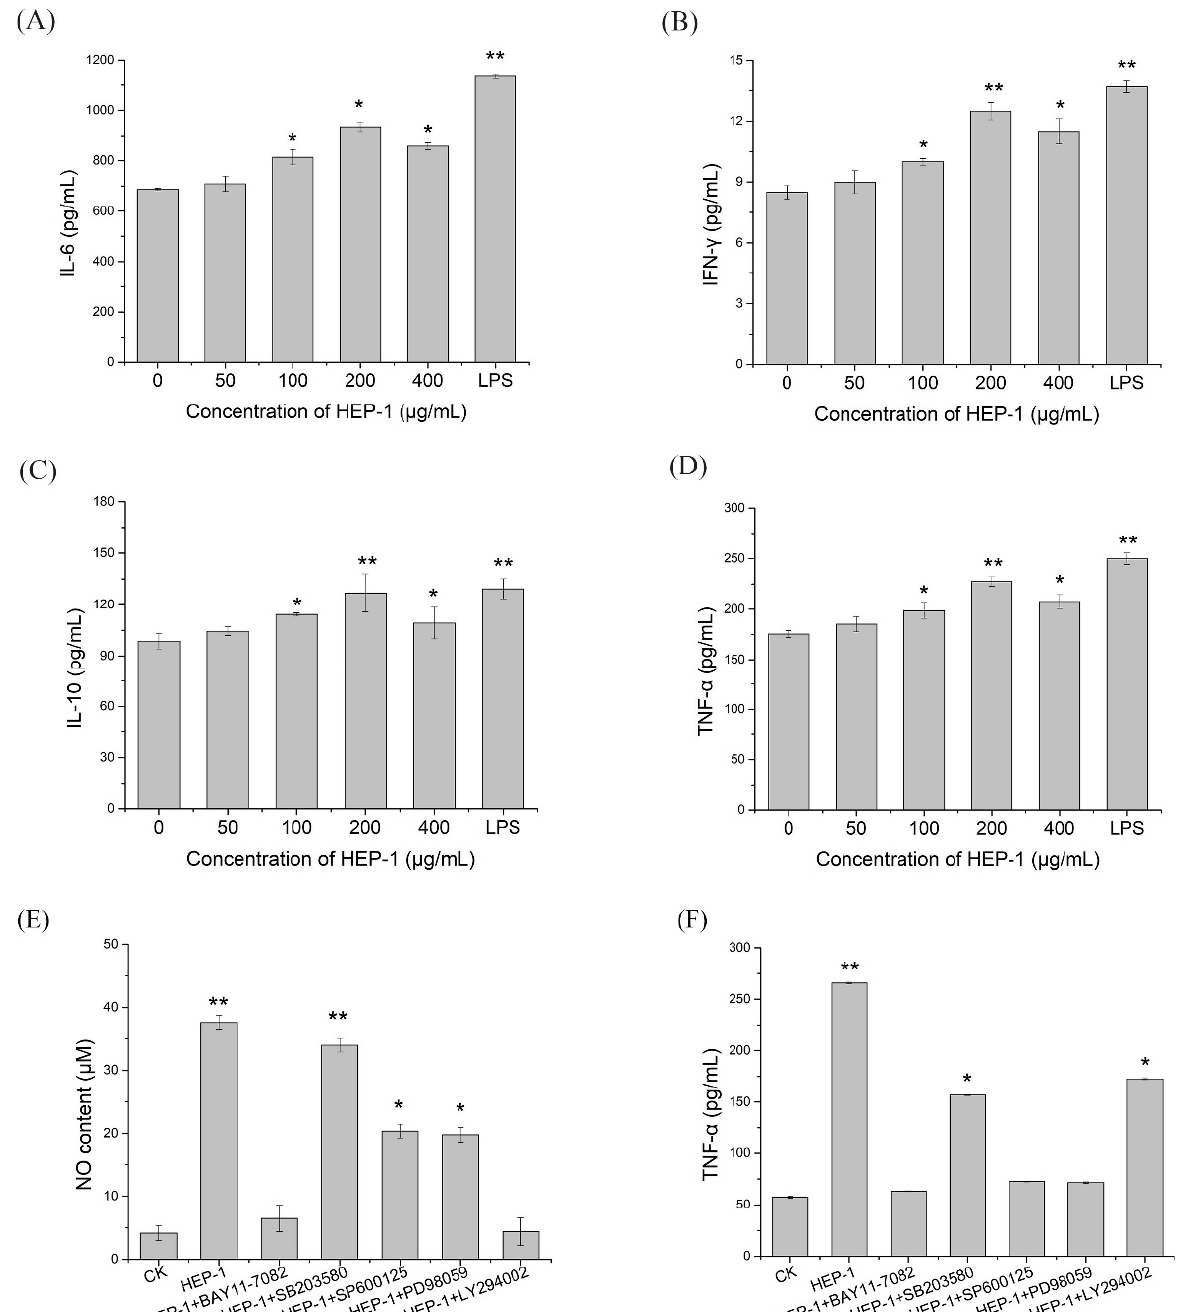
Figure 3. Effects of HEP-1 in RAW264.7/Caco-2 cells model. ( A ) IL-6. ( B ) IFN- γ . ( C ) IL-10. ( D ) TNF- α . After the treatment of inhibitors including BAY11-7082, SB203580, SP600126, PD98095 and LY294002, the release of ( E ) NO and ( F ) TNF- α in NF- к B, MAPK and PI3K/Akt signaling pathways were detected. Data are presented as mean ± SD ( n = 3). * p < 0.05, ** p < 0.01 compared with the CK group.